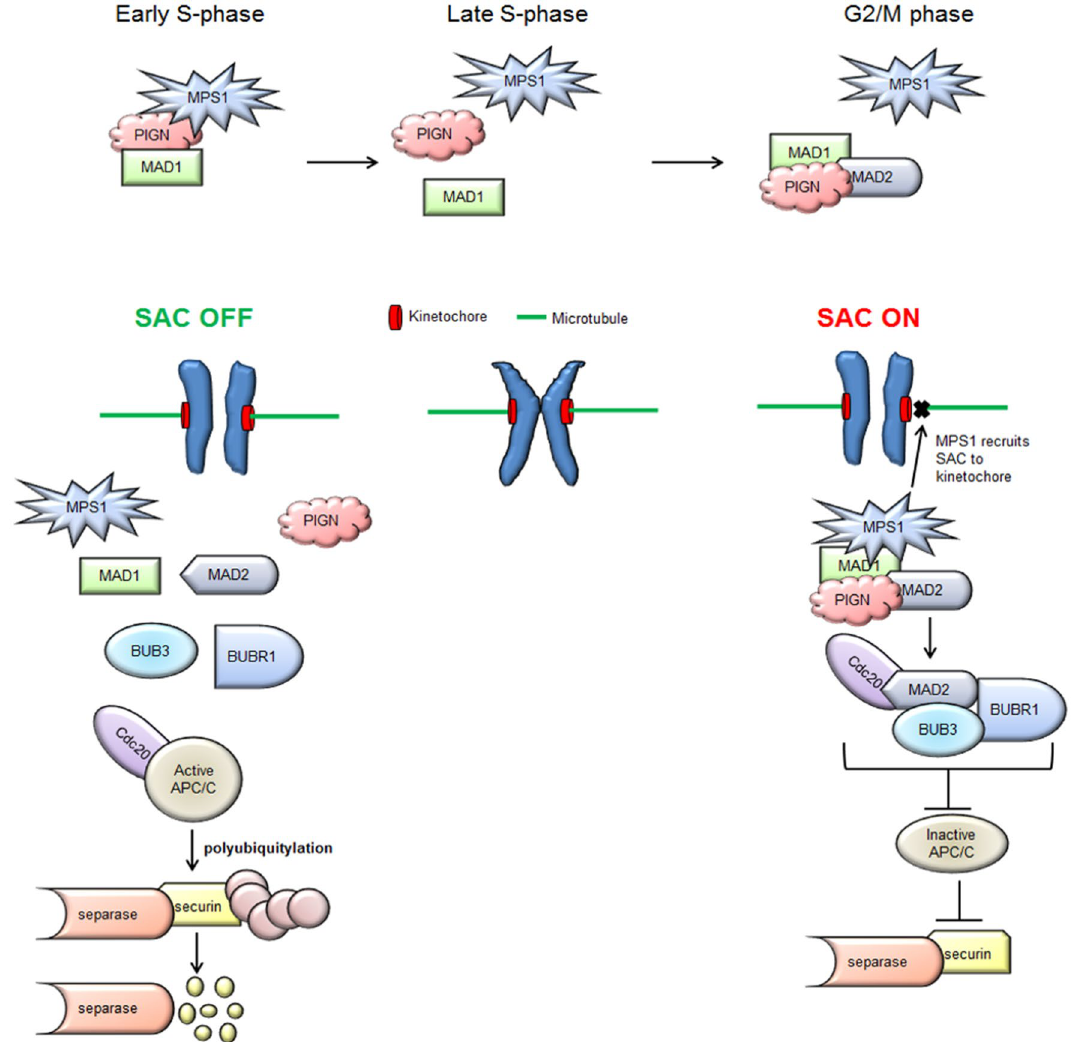
Figure 5. Simplified model of the spatiotemporal interaction between PIGN and SAC components during the cell cycle and SAC activation. PIGN interacts with SAC components in a time-dependent manner and may at some time points exclude interaction with